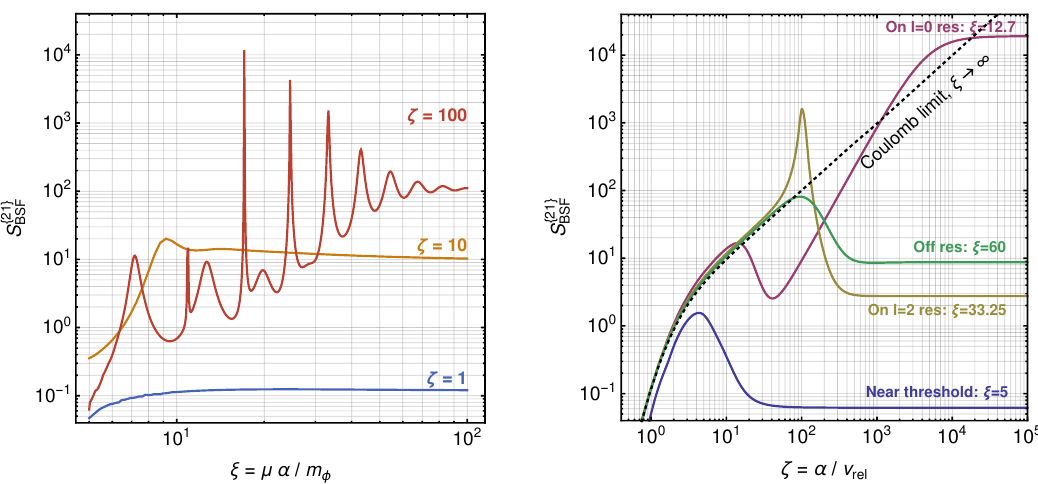
Figure 8 . Resonance structure and velocity dependence of the S f 21 g factor of the total cross- BSF section for the radiative capture into any n = 2 ; ‘ = 1 state of two particles with di(cid:11)erent masses and/or couplings, with emission of a scalar force mediator [cf. eqs. (4.7)]. Left: S f 21 g receives BSF contributions from the ‘ = 0 and the ‘ = 2 modes of the scattering-state wavefunction. The ‘ = 0 mode dominates for small (cid:24) , while the ‘ = 2 mode dominates for larger (cid:24) values (including the Coulomb regime) and gives rise to sharper resonances. Right: at large (cid:16) , the contribution from the ‘ = 2 mode decreases with decreasing velocity as v 4 , while the contribution from the ‘ = 0 mode rel saturates to a constant value and